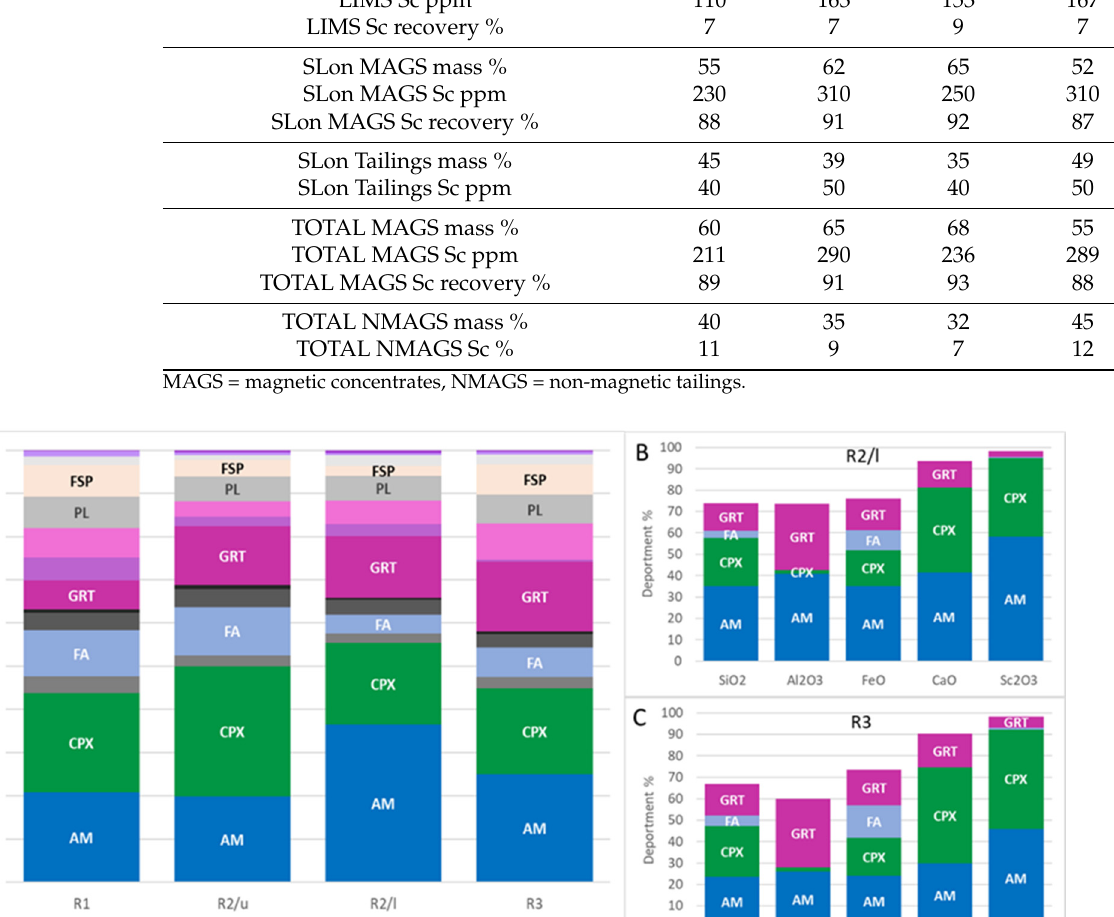
Table 3. Chemical compositions of concentrates used in high-temperature experiments. Composi- tions calculated based on modal mineralogy are also provided for comparison. Sc 2 O 3 presented in ppm, other oxides in wt%.